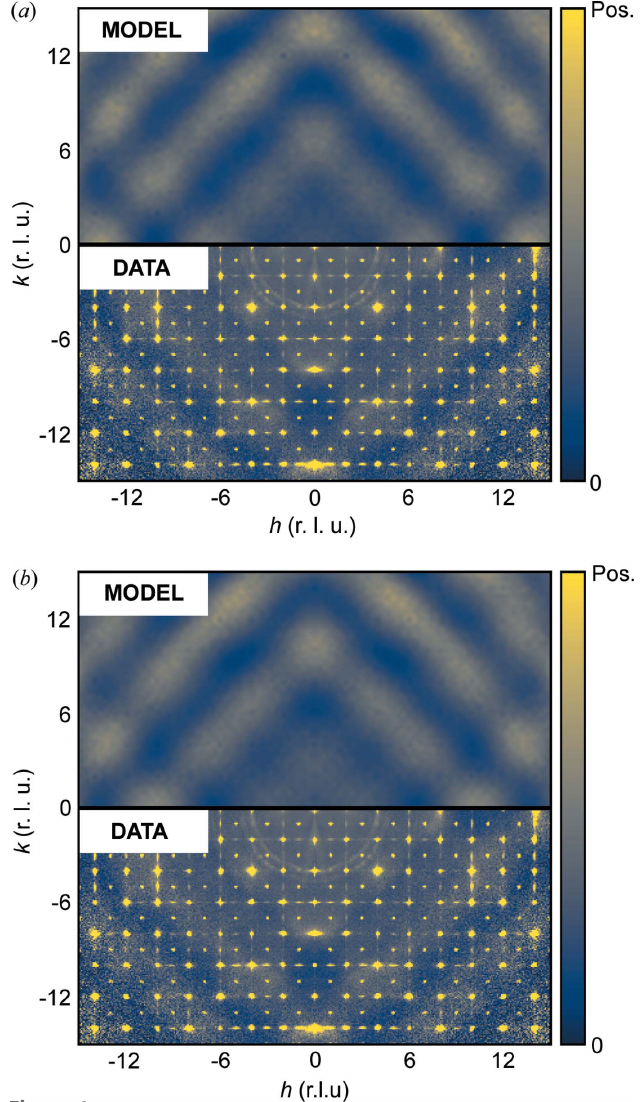
Figure 6 Experimental and modelled single-crystal neutron diffuse scattering data for ( a ) a model assuming oxide displacing away from Fe and towards Mn with the opposite sign of displacements for the axial oxides in the distorted 24 d site octahedron and ( b ) a model where all the signs of the oxide displacements have been inverted with respect to ( a